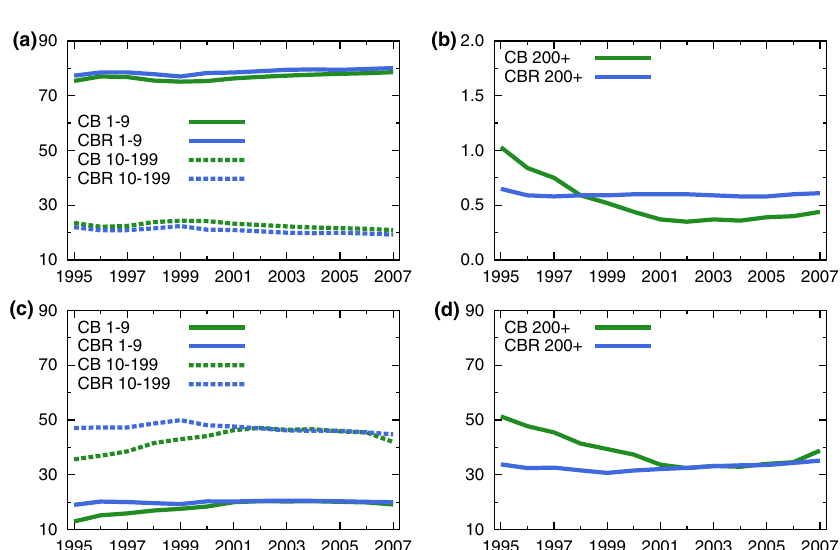
Fig. 6 Size distribution of firms, 1995–2007. Notes a plots the percentage number of firms with 1–9 workers and 10–199 workers both for our sample from the Central de Balances (CB) and for the census from the Central Business Register (CBR). b Does the same for firms with 200 + employees. c , d Report the employment shares in the same size